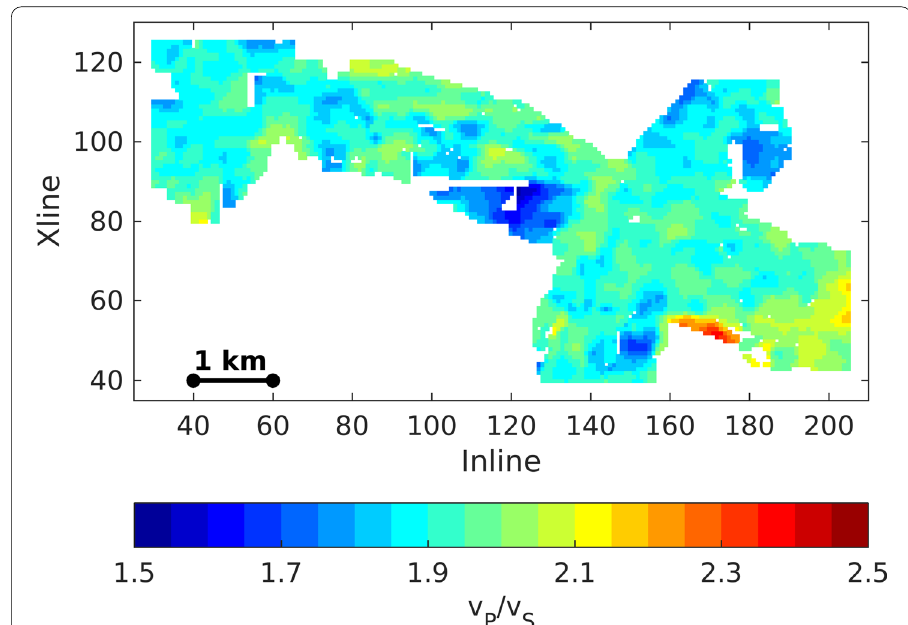
Fig. 9 v p /v s within the Molasse. v p /v s ratio for the lower Molasse units between Top Chattian and Top Priabonian, showing values vary around a median of 1.92